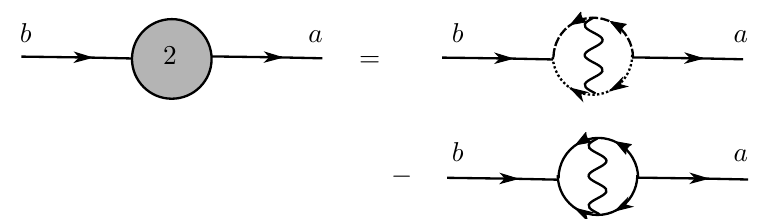
Figure 8 . The irreducible two-loop correction to the scalar propagator in the N = 2 superconformal theory. The (cid:12)rst diagram on the right hand side is the Q -contribution involving the fundamental hypermultiplets, while the second diagram is the H -contribution due to the adjoint hypermultiplet which therefore comes with a minus sign.